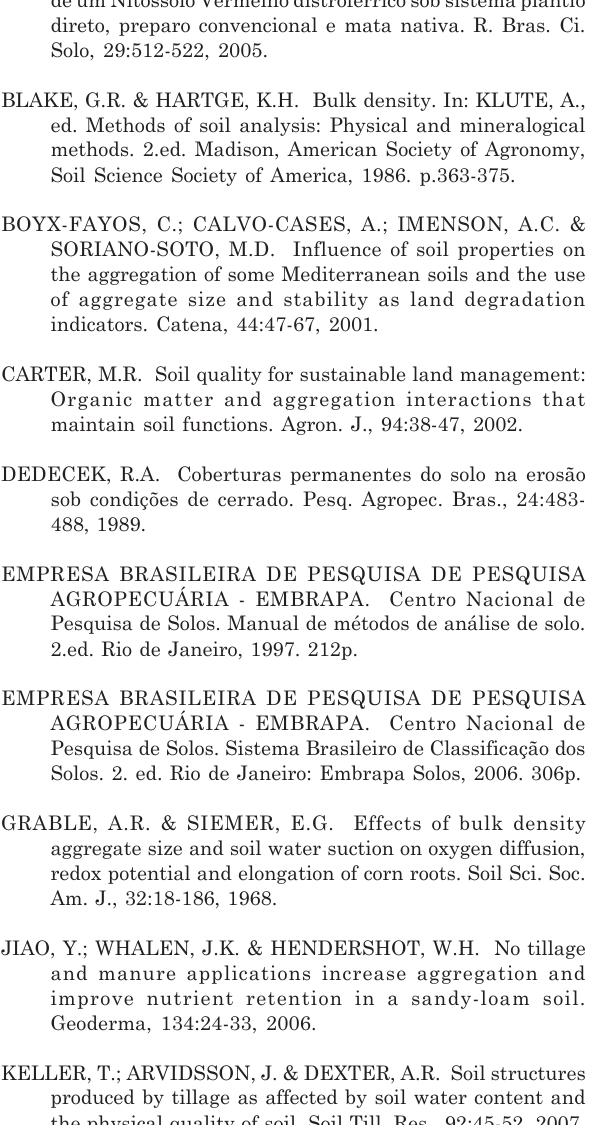
Figura 2. Relação obtida entre macroporosidade (M e densidade (D ) de um Planossolo Háplico. S Quadro 3. Parâmetros dos modelos: (i) Ds